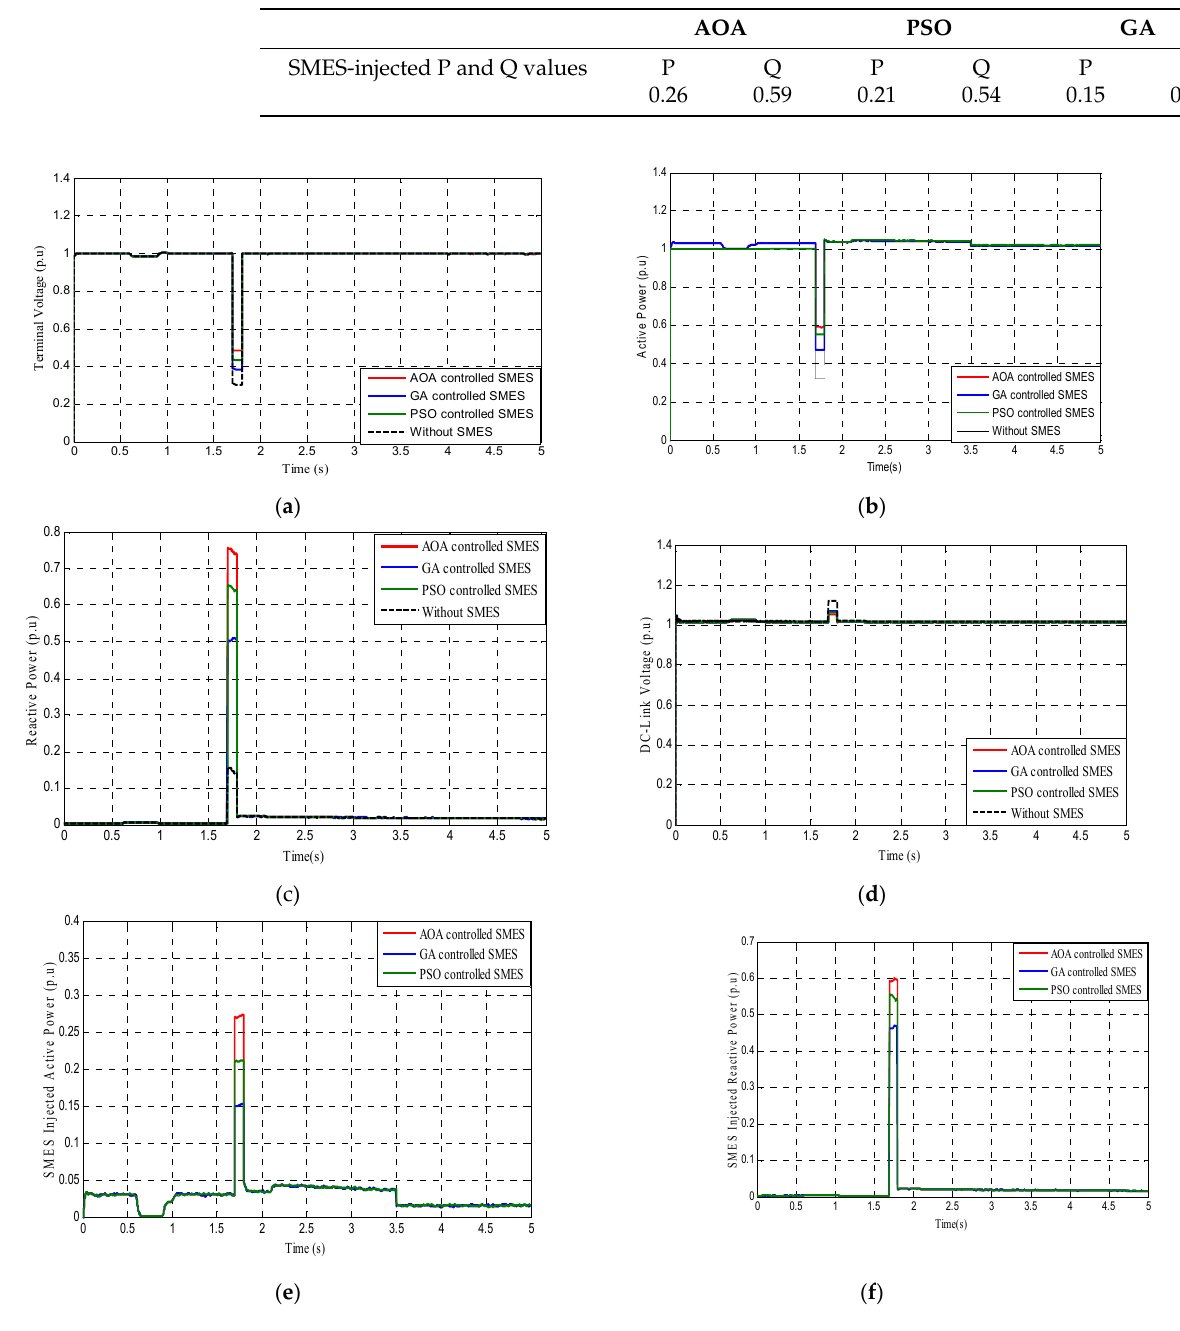
Figure 13. Simulation curves for L ‐ L fault using the AOA, the GA, and PSO: ( a ) terminal voltage; ( b ) P curve; ( c ) Q curve; ( d ) DC link voltage curve; ( e ) SMES ‐ injected active power; ( f ) SMES ‐ injected reactive power.